Question: Name the type of graph shown.
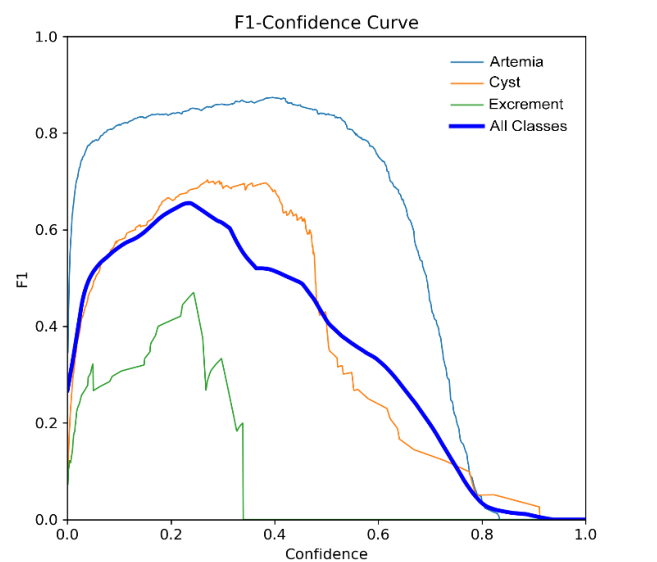
Answer: line